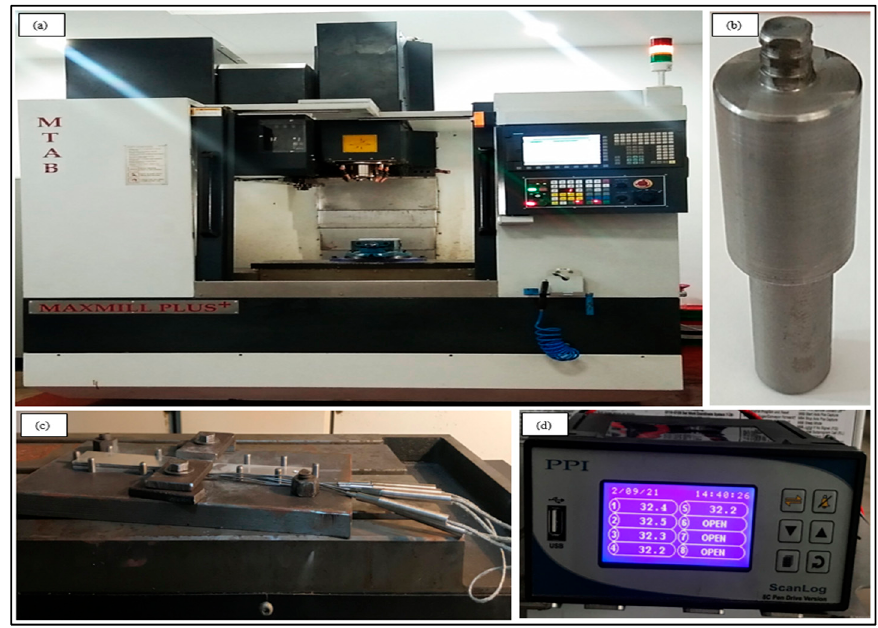
Figure 3. Experimental setup: ( a ) CNC milling machine; ( b ) FSSW tool; ( c ) fixture and thermocouple arrangement; ( d ) data logger.